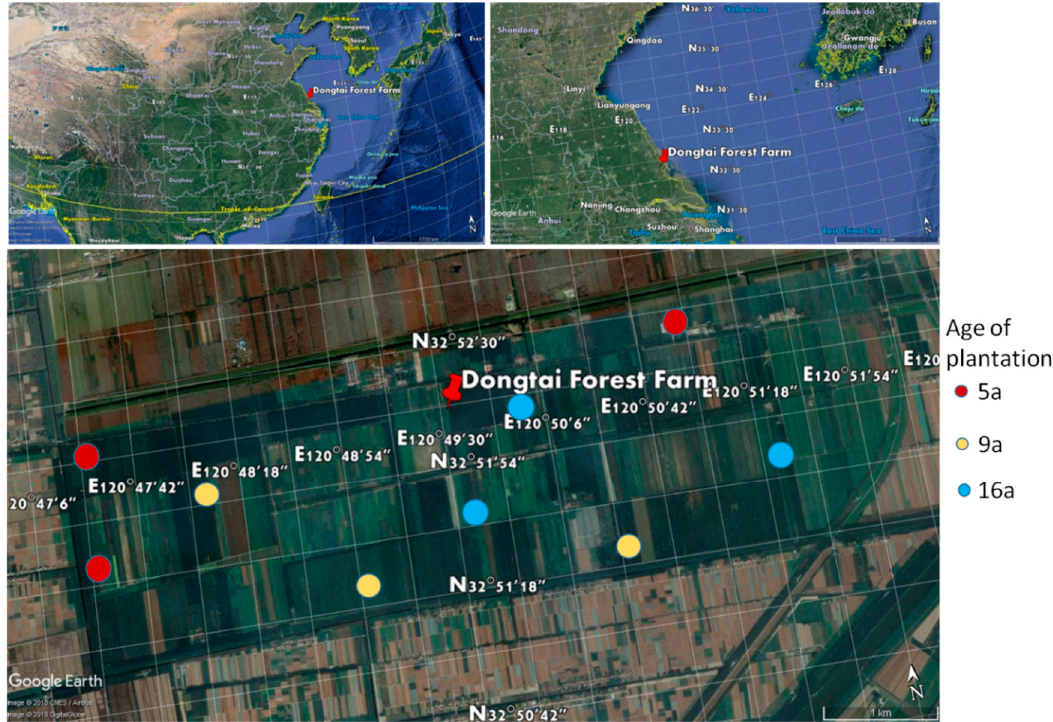
Figure 1. The location of Dongtai Forest Farm and sampling sites.